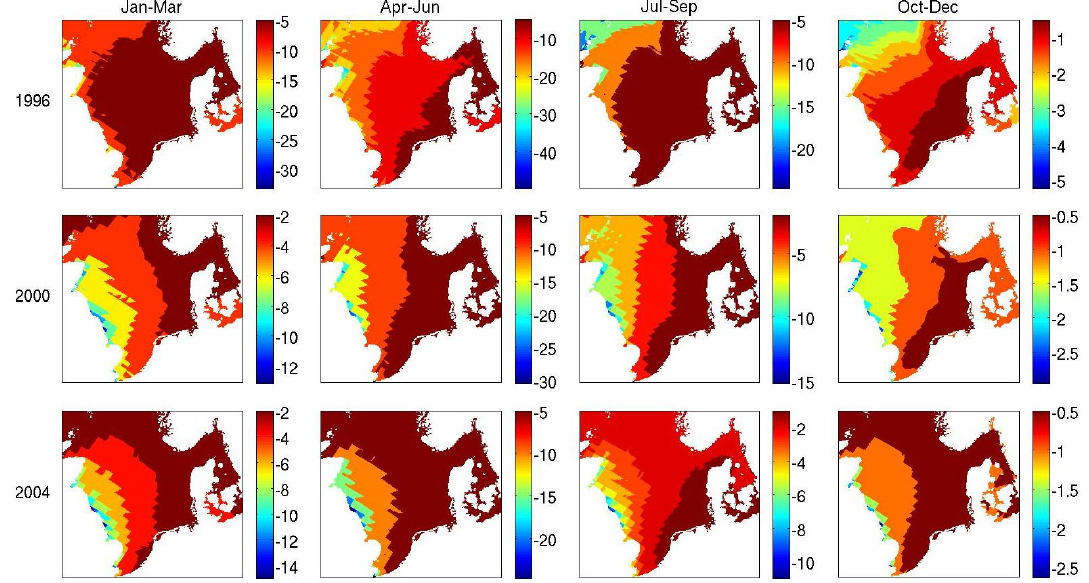
Figure 14. Distributions of quarterly (3 month) averaged fugacity ratios for γ-HCH in 1996, 2000 and 2004, calculated as minus the ratio of gas deposition to